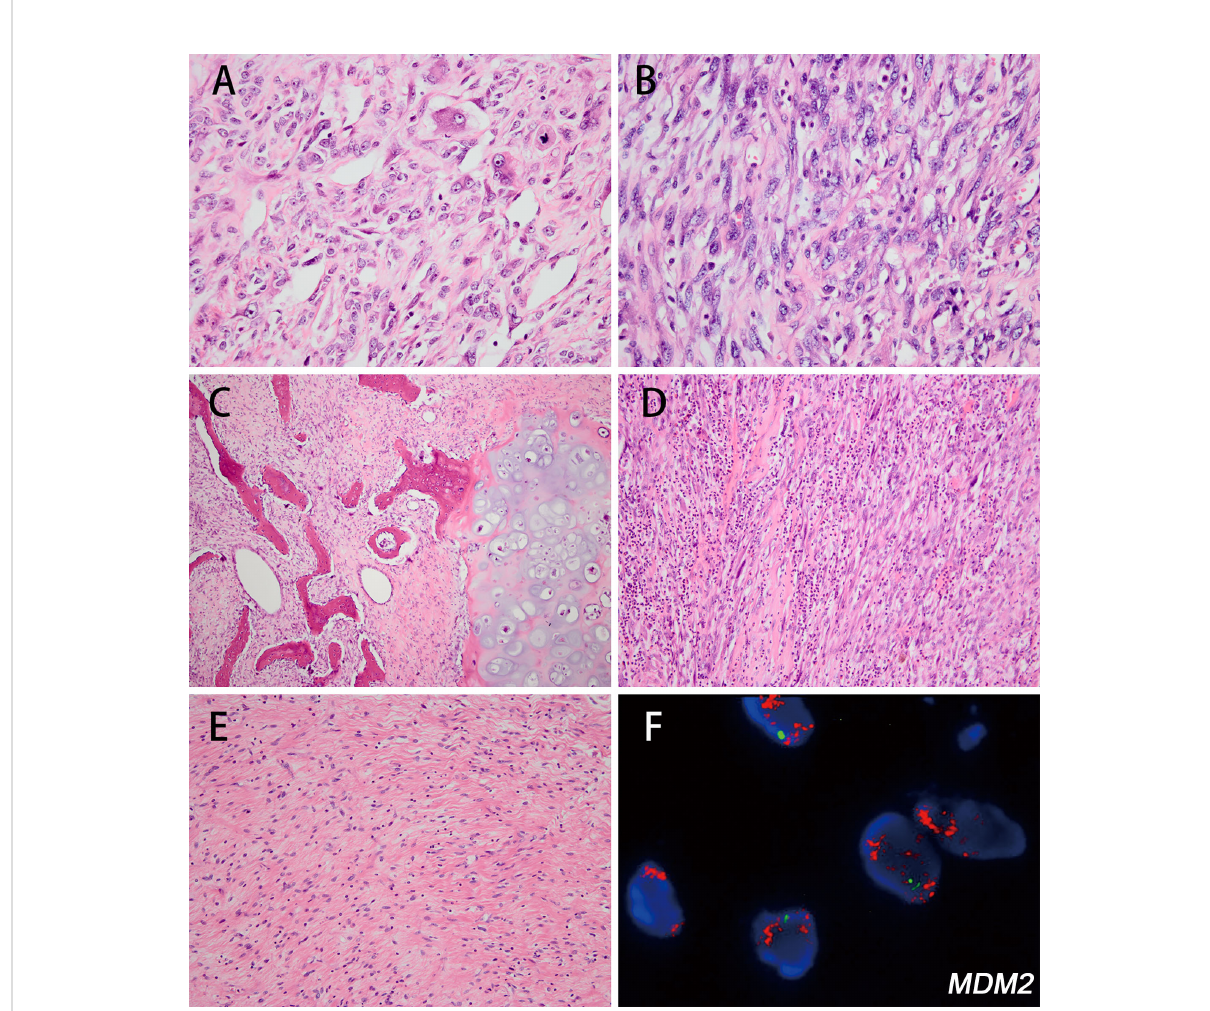
FIGURE 3 The histologic features of dedifferentiated liposarcoma (DDL) and corresponding fl uorescence in situ hybridization (FISH) images. DDL with undifferentiated pleomorphic sarcoma-like differentiation; tumor cells exhibited moderate cytologic atypia with obvious nuclear pleomorphism ( A H&E; magni fi cation: 400×). DDL showed a fi brosarcoma-like pattern, exhibiting marked hypercellularity and cytologic atypia. ( B H&E; magni fi cation: 400×). DDL showing areas of osteosarcoma and chondrosarcoma-like differentiation ( C H&E; magni fi cation: 100×). DDL with IMT-like features with varying degrees of chronic in fl ammatory cell in fi ltration ( D H&E; magni fi cation: 200×). DDL with low-grade fi brosarcoma-like differentiation, exhibiting mild cytologic atypia ( E H&E; magni fi cation: 200×). FISH analysis identi fi ed MDM2 ampli fi cation in the DDL (case 32) (F)